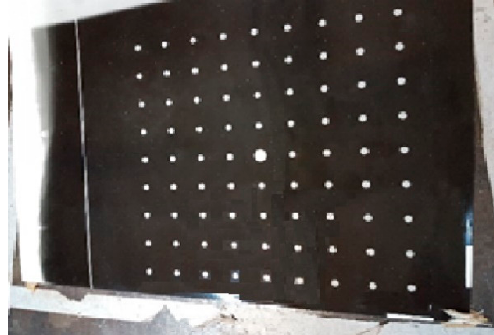
Figure 14. Calibration board made of photographic paper printed with light through etched glass used to calibrate the camera intrinsic parameters, with 9 × 9 dots of 26.5 ± 0.1 mm from each other.